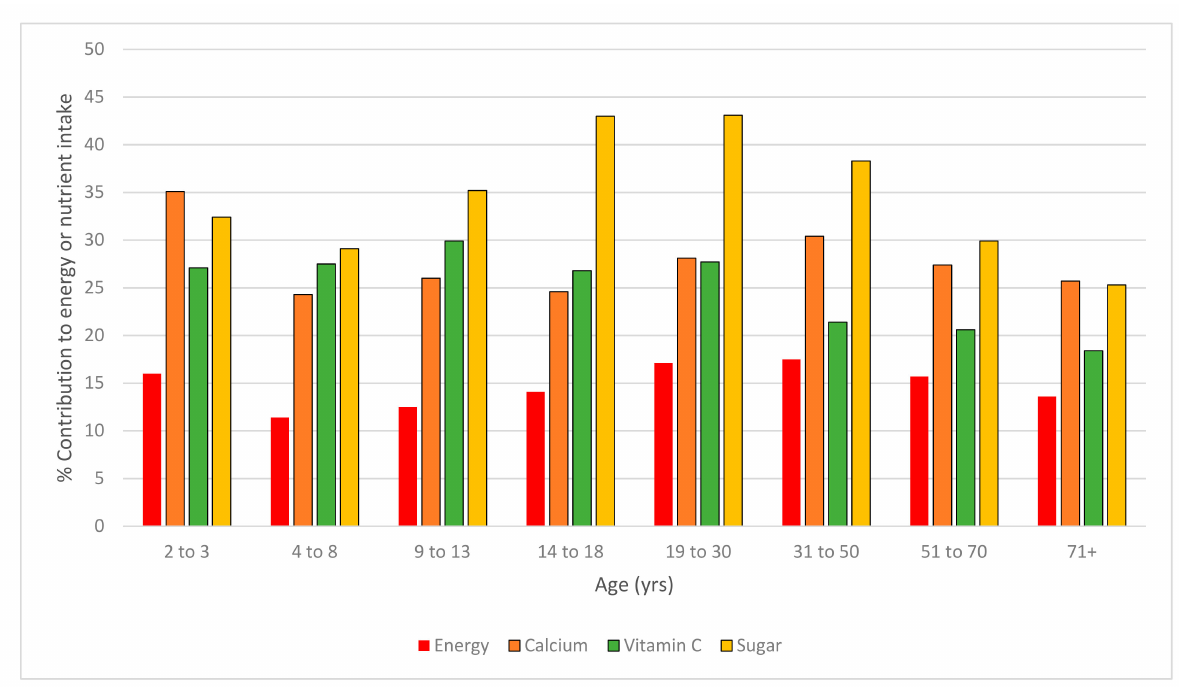
Figure 1. The percentage contribution of total beverage intake to total dietary energy, calcium, vitamin C, and sugar intake by age